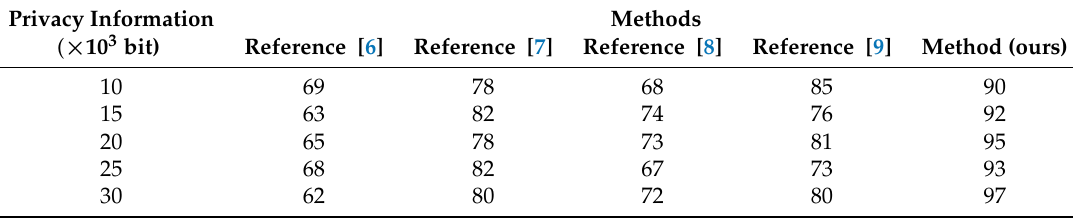
Table 1. Comparison of utilization rates of information resources of the proposed method with